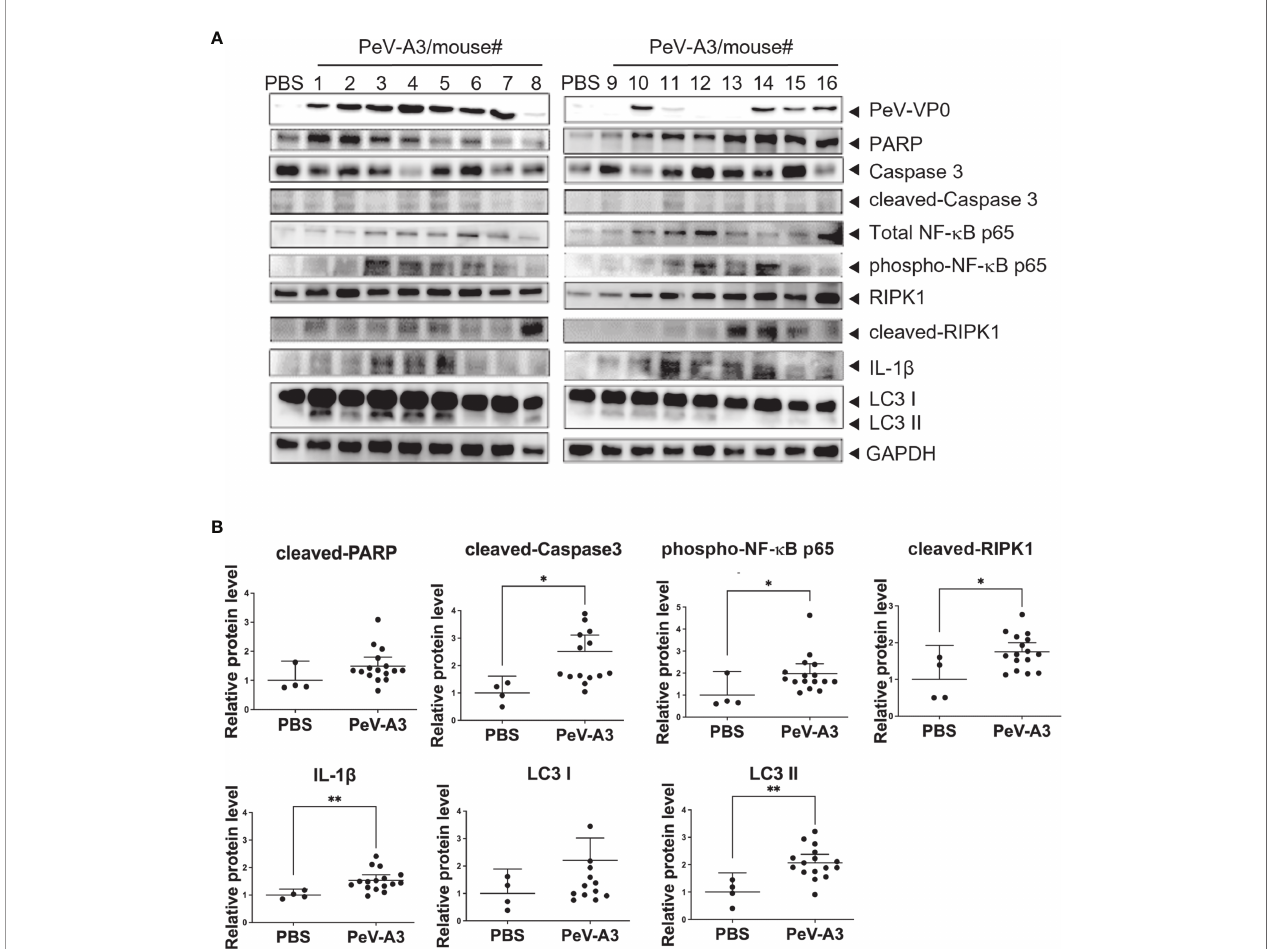
FIGURE 9 | PeV-A3 induced signal transduction proteins in mouse brain tissues. (A) Immunoblotting of PARP, caspase 3, LC3, phospho-NF- k B p65 (Ser536), IL- 1 b , and RIPK1 in two PBS control and 16 PeV-A3 mouse brain tissues (#1-#16). (B) Quanti fi cation of protein expression level of PeV-A3-infected mice and PBS mock controls. Data are mean ± SD, PBS group N = 4, PeV-A3 group N = 16. Independent two-sample t-test, * p < 0.05 ** p < 0.01 compared with PBS mock controls. PeV-A3, parechovirus type 3; PBS, phosphate-buffered